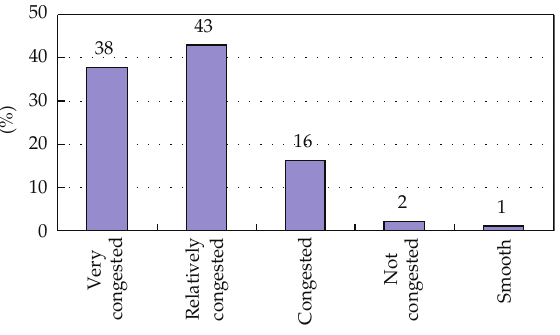
Figure 3: Tra ffi c congestion.